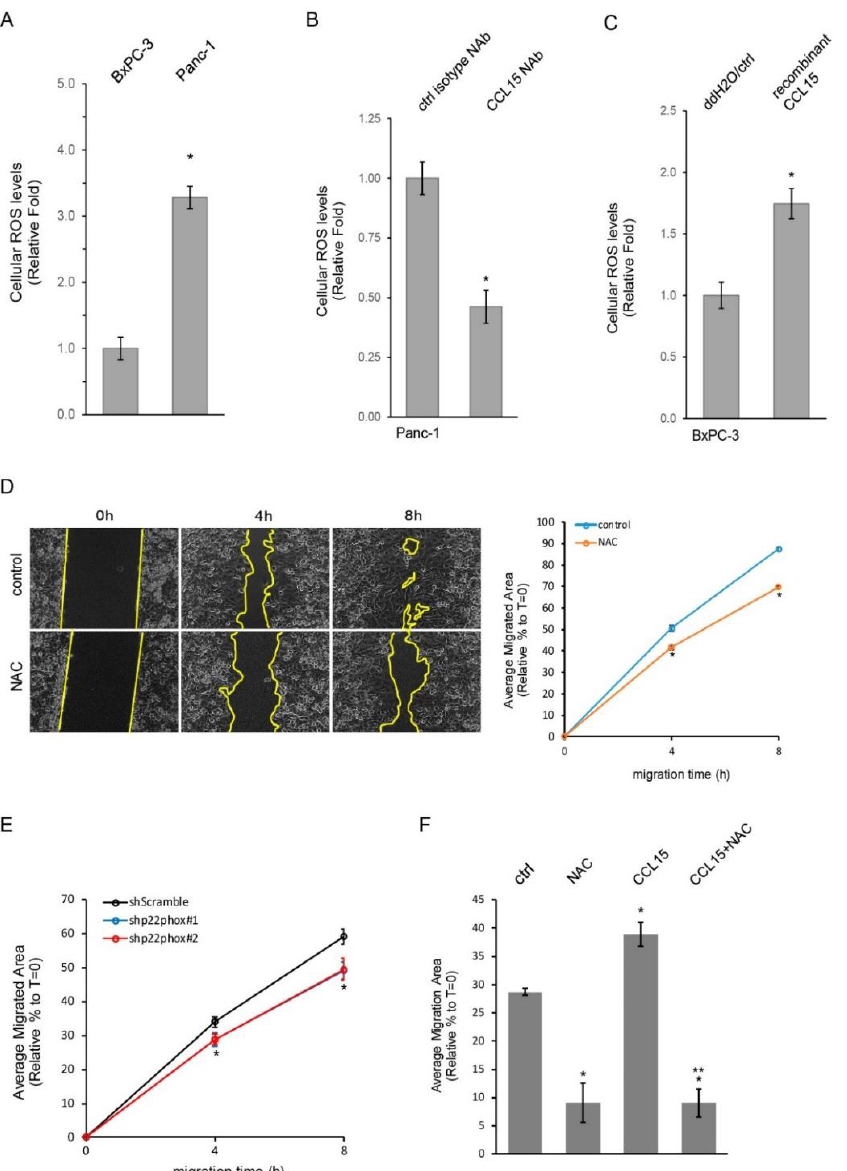
Figure 4. Depletion of reactive oxygen species attenuated CCL15-induced PDAC cell migration. ( A ) Cellular ROS levels of BxPC-3 and Panc-1 cells were detected as described in Section 2 and graphed. *: p < 0.05 as compared to BxPC-3. ( B ) Panc-1 cells were treated with an isotype control NAb or a CCL15 NAb (5 µg/mL) and subjected to detection of cellular ROS levels. *: p < 0.05 as compared to isotype NAb treatment. ( C ) BxPC-3 cells were treated with either control (ddH 2 O) or recombinant CCL15 (100 ng/mL) for 24 h followed by cellular ROS measurement. *: p < 0.05 as compared to control. ( D ) Panc-1 cells were seeded in culture-inserts as described in Section 2. After removal of culture-inserts, 5 mM NAC was added to the media, and Panc-1 cell migrated into the existing gap areas (yellow lines indicate the cell migration front lines) at the indicated time points and documented. The migrated areas were measured using Image J and calculated as a percentage relative to the areas at t = 0 in each condition. *: p < 0.05 as compared to control at the same migration time point. ( E ) Similar to ( D ), Panc-1 cells stably expressing shScramble, shp22phox #1, or shp22phox #2 were assessed for their cell migration ability at the indicated time points. *: p < 0.05 as compared to shScramble at the same migration time point. ( F ) BxPC-3 cells treated with 50 ng/mL recombinant CCL15 in the presence or absence of 5 mM NAC were examined for their cell migration abilities. *: p < 0.05 as compared to control. **: p < 0.05 as compared to recombinant